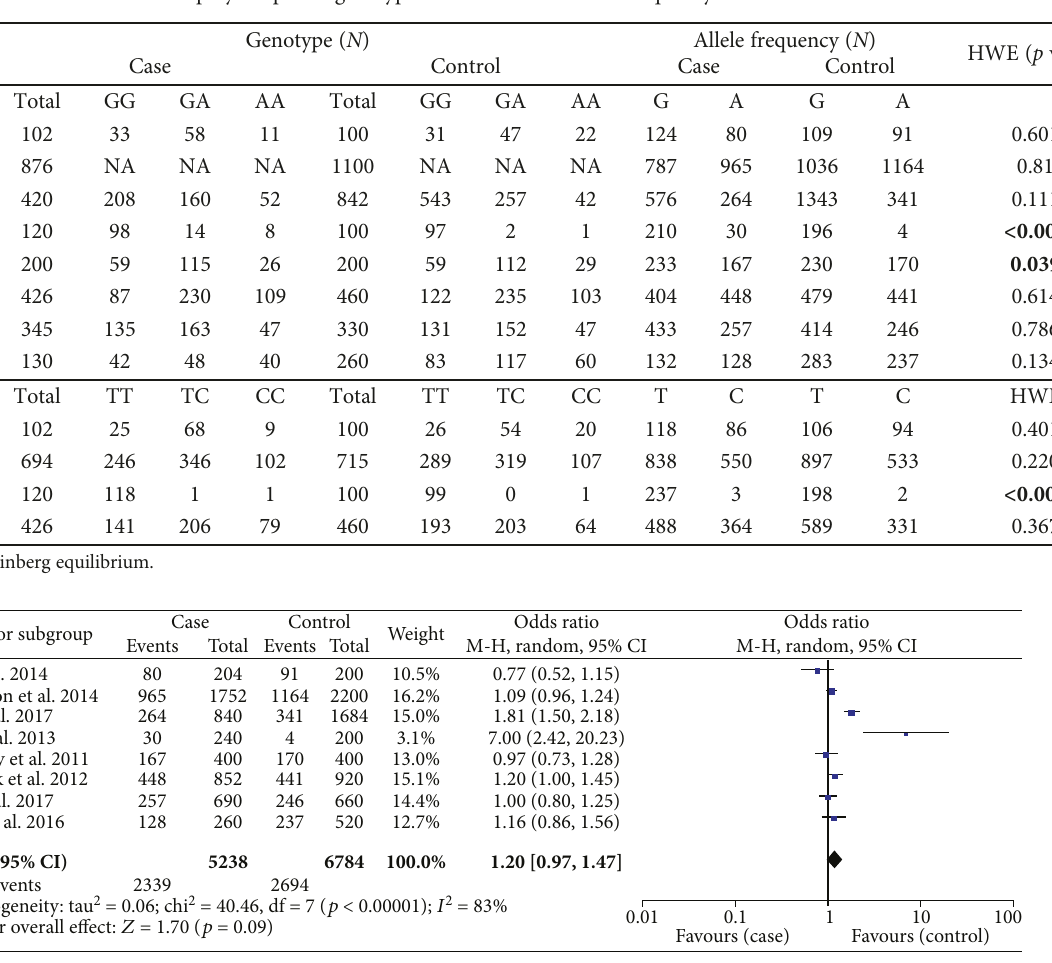
Figure 2: Forest plots of the association between TLR9 rs352140 polymorphism and cervical cancer risk in the allele genetic